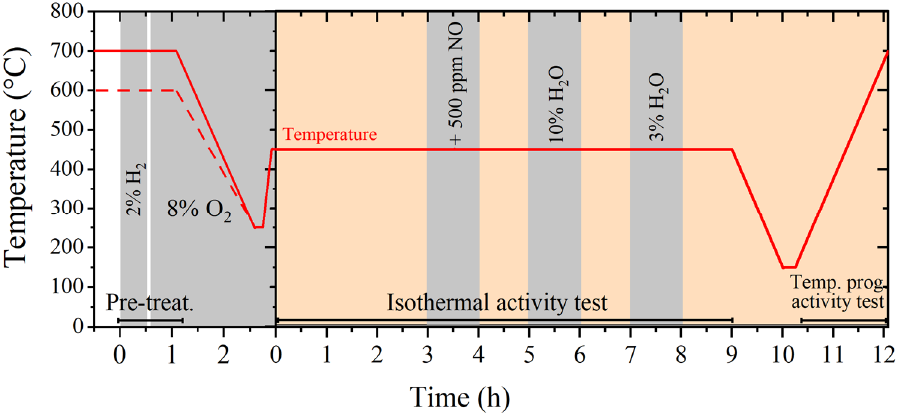
Figure 7. Illustration of the experimental procedure for the pre-treatment, isothermal activity test and the temperature programmed activity test. Note that orange areas correspond to wet reaction mixture. Modifications of the wet reaction mixture during the activity test can be seen in the figure (grey areas).